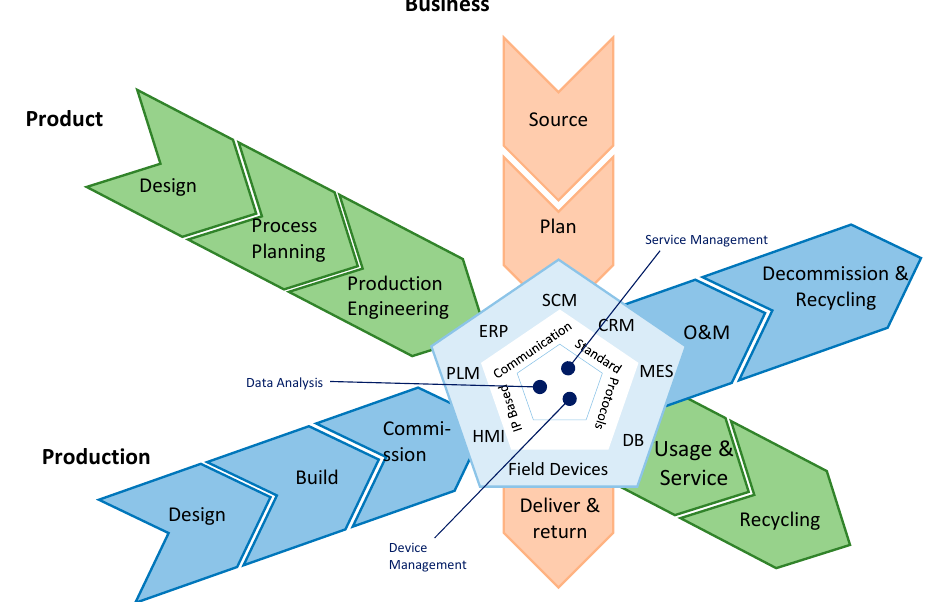
Figure 3. Smart Manufacturing Ecosystem Perspectives.